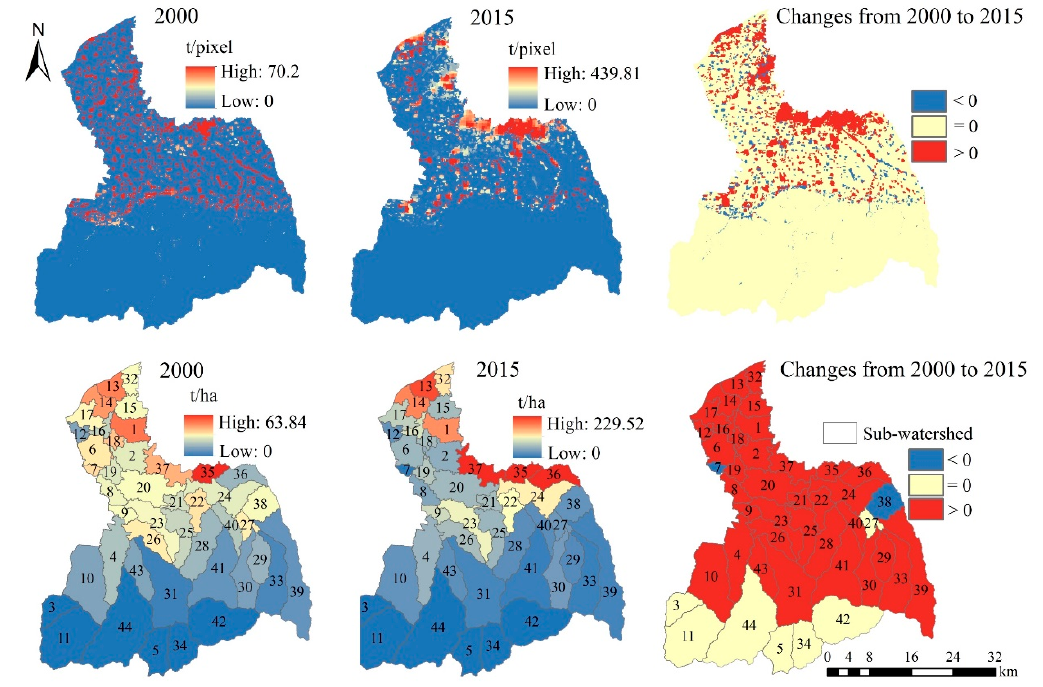
Figure 11. The spatial distribution and spatial–temporal changes of carbon emissions.